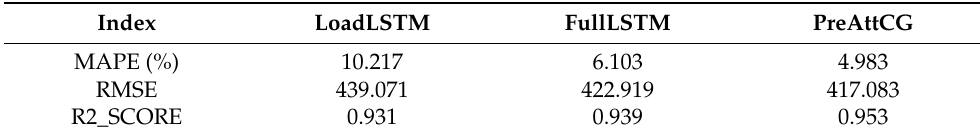
Table 3. Comparison of prediction accuracy indexes (German dataset).